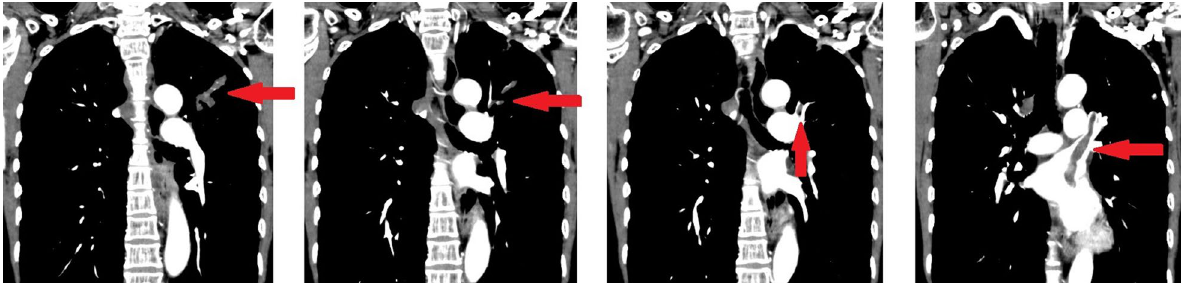
Fig. 6 Contrast computed tomography showing enlarged lung metastases and that disease in the left-upper lobe has infiltrated the left superior pulmonary vein and left atrium